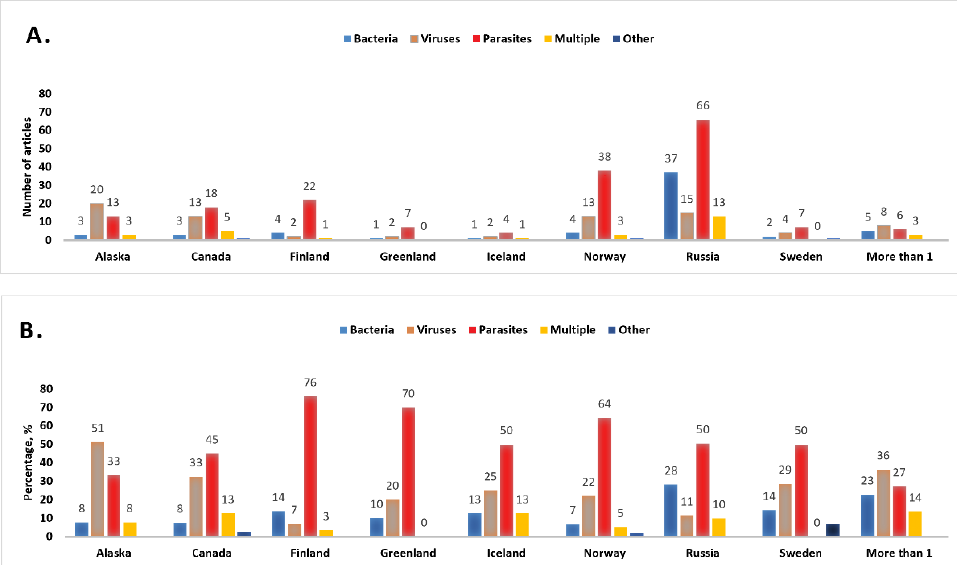
Figure 6. Types of infection in mammals and birds featured in articles by country of research in absolute numbers ( A ) and in percentage to the total amount of papers per country ( B ). “More than 1” refers to articles that have research in more than one country, and “Multiple” refers to articles that include more than one type of infection. “Other” refers to infections including prions, fungi, and arthropods (there were few publications in these areas, and they were therefore combined).